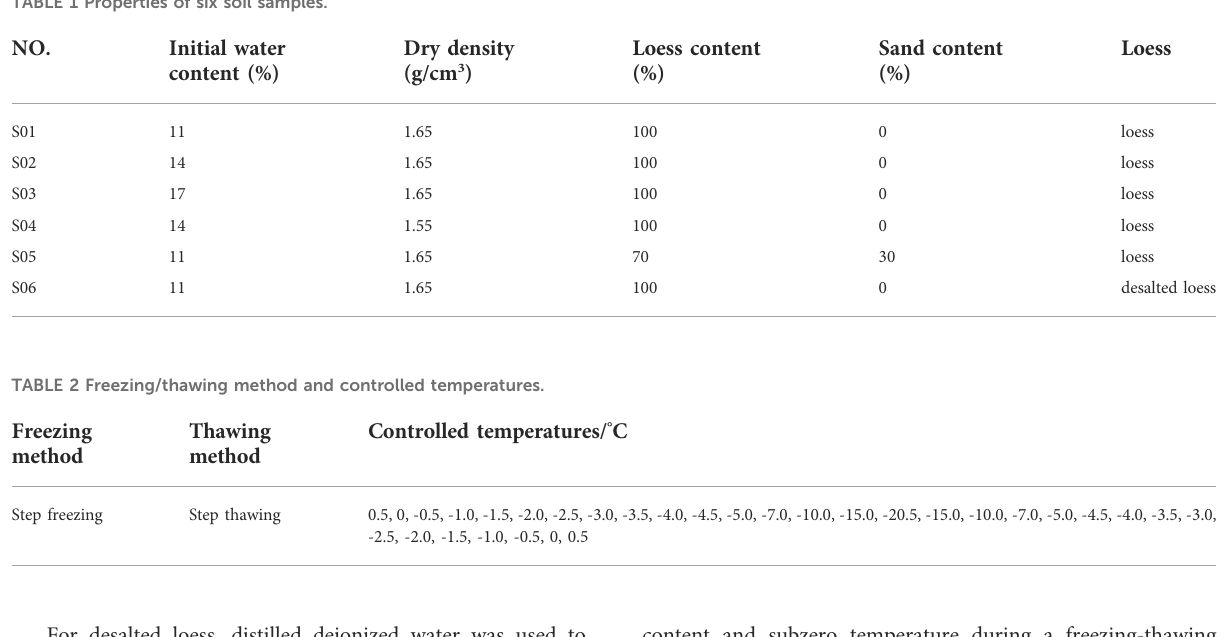
TABLE 1 Properties of six soil samples.